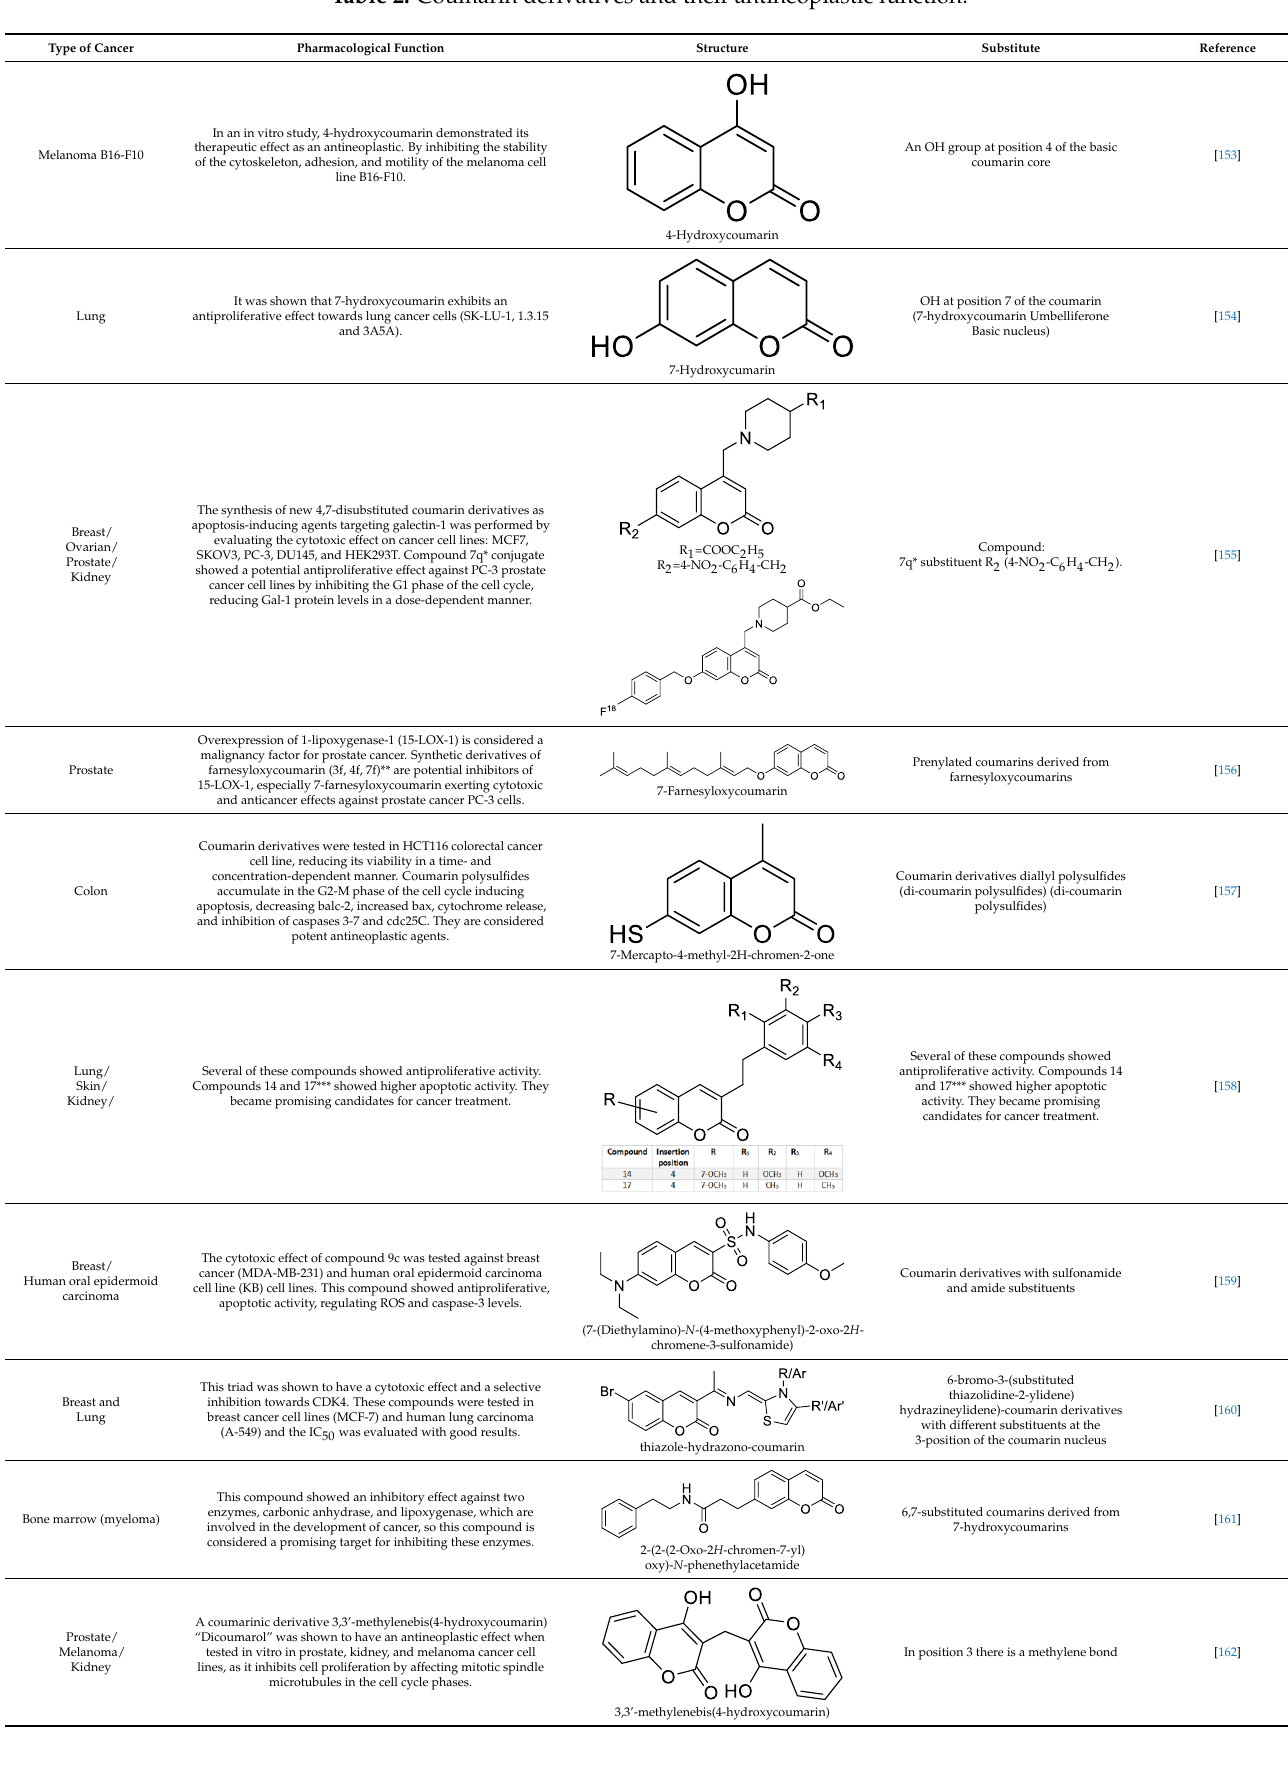
Table 2. Coumarin derivatives and their antineoplastic function.